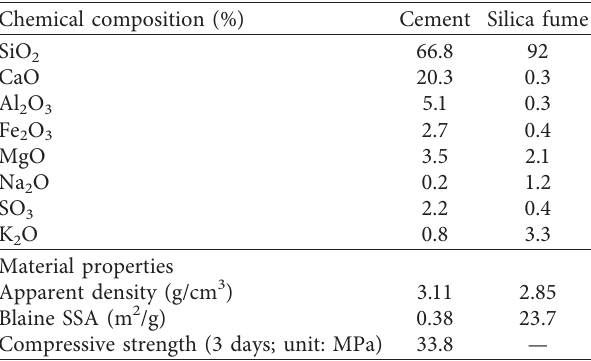
Table 1: Chemical and material